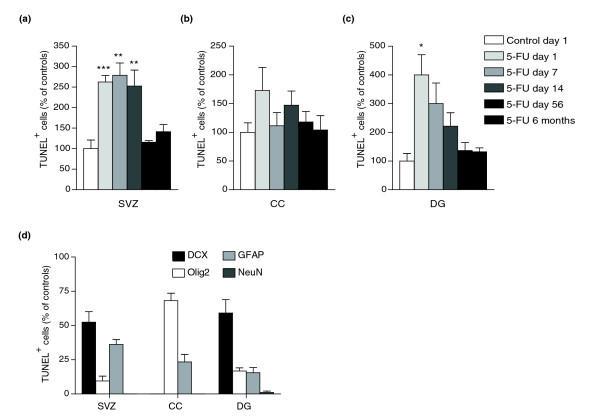
Systemic 5-FU treatment causes cell death in the adult CNS. Cell death was determined using the terminal deoxynucleotidyltransferase-mediated dUTP nick-end labeling (TUNEL) assay. The number of TUNEL+ cells was analyzed in control animals (that received 0.9% NaCl i.p.) and 5-FU-treated animals and presented as percentage normalized values of controls at each time point. For ease of comparison, data presented in the figures show the control value (mean set at 100% of the day 1 value) and normalized values of 5-FU treatment groups at all time points. Each treatment group and the control group consisted of n = 5 animals at each time point. Figures show apoptosis in animals that received three bolus i.p. injections of 5-FU (40 mg kg-1 on days -4, -2 and 0 leading up to the analysis, where day 1 of analysis equals 1 day after the last treatment with 5-FU). There was marked and prolonged increase of cell death in the 5-FU treatment group in (a) the lateral subventricular zone (SVZ), (b) the corpus callosum (CC) and (c) the dentate gyrus (DG) at 1, 7, 14 and 56 days and 6 months following treatment. Data are means ± s.e.m.; a two-way ANOVA test was performed on the original un-normalized data set to test the statistical significance of treatment effect and time effect. Bonferroni post-tests were performed to compare the 5-FU-treated group and the control group at each time point. The statistical significance of the Bonferroni post-tests is labeled in the graphs where applicable: ***p < 0.001; **p < 0.01; and *p < 0.05. Two-way ANOVA test results indicate that, in the SVZ, the treatment effect is extremely significant (p < 0.001), the time effect is very significant (p < 0.01); in the CC, the treatment effect is not quite significant (p = 0.06), the time effect is not significant (p = 0.74); in the DG, the treatment effect is extremely significant (p < 0.001), the time effect is significant (p < 0.05). The effect of the interaction between treatment and time is not significant for all three regions. (d) To determine the immediate cellular targets of 5-FU in vivo, we examined co-analysis of TUNEL labeling with antigen expression in animals sacrificed at day 1 after completion of 5-FU treatment. The majority of TUNEL+ cells in the SVZ and DG were doublecortin (DCX)+  neuronal progenitors. Other TUNEL+ cells in these two regions included GFAP+ cells (which could be stem cells in the SVZ, or astrocytes in the DG) and Olig2+ O-2A/OPCs. There was also a small contribution of NeuN+ mature neurons in the DG. In the CC, the majority of TUNEL+  cells were Olig2+ (which, in this white matter tract, would be oligodendrocytes and O-2A/OPCs), with a small contribution of GFAP+ astrocytes. Almost 100% of TUNEL+  cells were accounted for by known lineage markers. Each group consisted of n = 4 animals. Data are mean ± s.e.m.